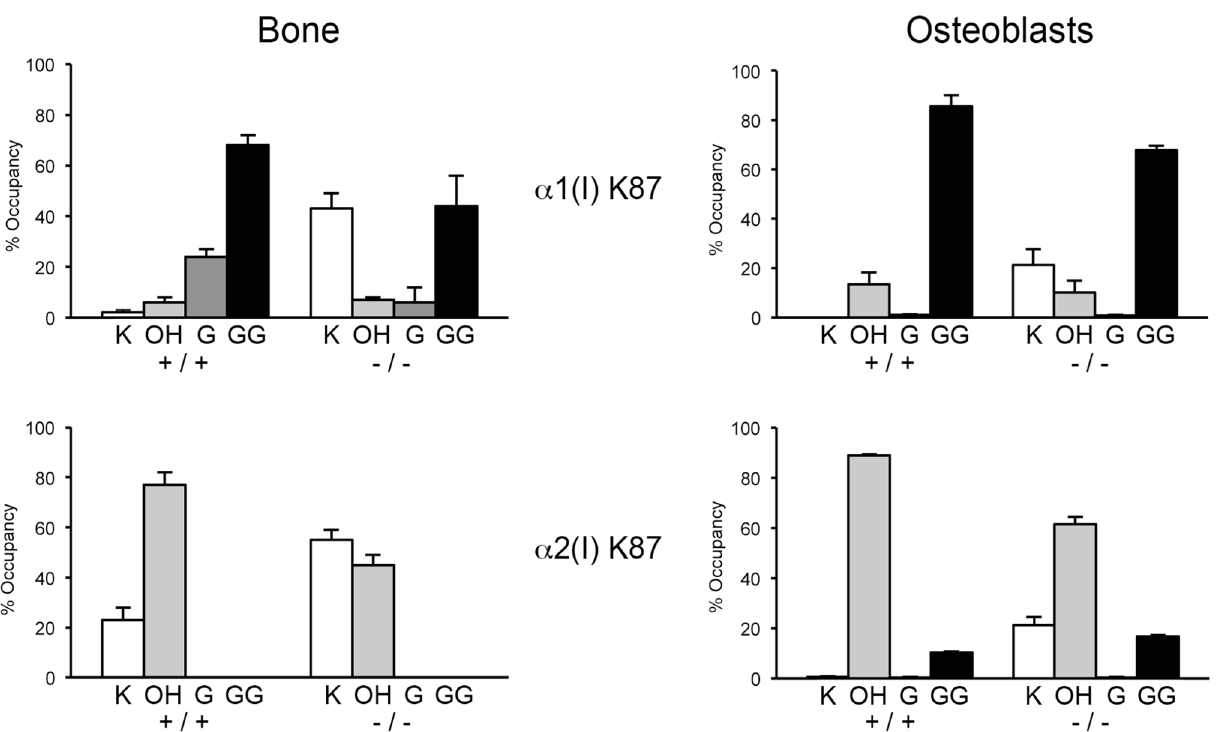
Figure 7. Altered post-translational modification of specific type I collagen lysine residues in the absence of Ppib. Quantitation of type I collagen modifications at a 1(I) and a 2(I) K87 residues, which are important for crosslinking of type I collagen heterotypic fibrils in tissue. Results were obtained from collagen secreted in culture by primary osteoblasts, or from 3–5 independent tissue samples for each genotype. K, lysine; OH, hydroxylysine; G, galactosylhydroxylysine; GG,